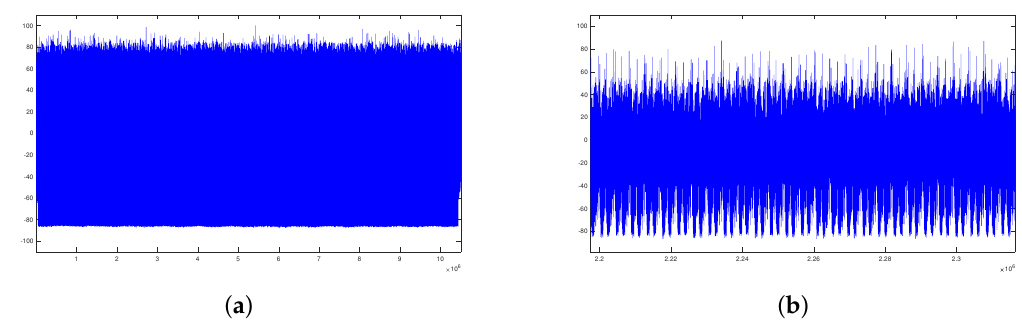
Figure 7. Iteration of Addition. ( a ) Full Trace of Countermeasure; ( b ) Enlarged Trace of